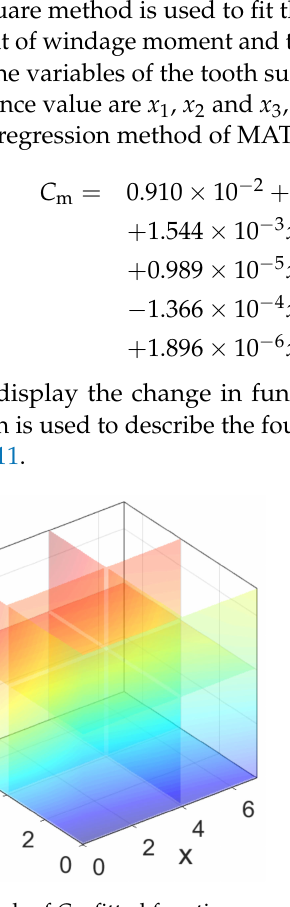
Figure 11. Slice graph of C m fitted